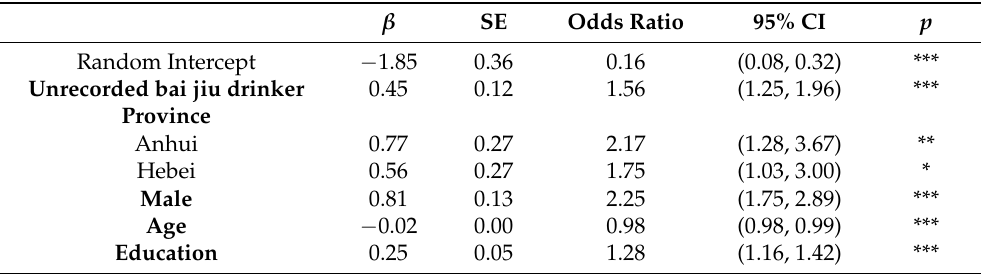
Table 9. Two-level logistic regression model of the effect of unrecorded bai jiu drinker and province on pushing others to